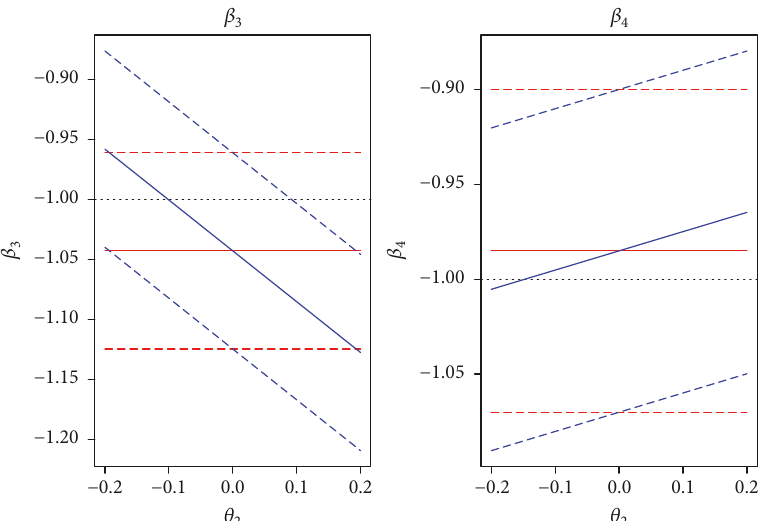
Figure 4: CI under MAR: 𝛽 = (−2,−2, −1, −1) , 𝜃 = (−0.5, −0.5) , 𝜃 𝑇 2 =0. The blue lines are the adjusted estimates, and red lines are the unadjusted estimates. The horizontal dotted lines are at the true